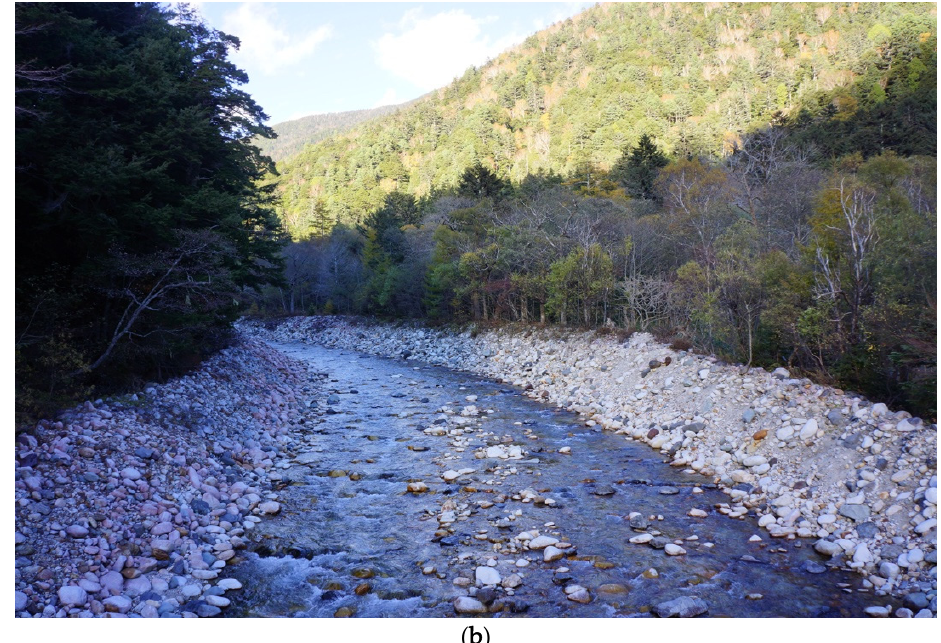
Figure 4. Subtle or clear anthropogenic modifications of the environment are widespread in Kamikochi. ( a ) (above) Tourists enjoying a sunny day on the gravelly bed of the Azusa River in Kamikochi; note the artificial enforcement of the bank in the foreground. ( b ) (below) The relatively straight single thread channel is the result of flow modification and embankment engineering. Photos provided by the author.